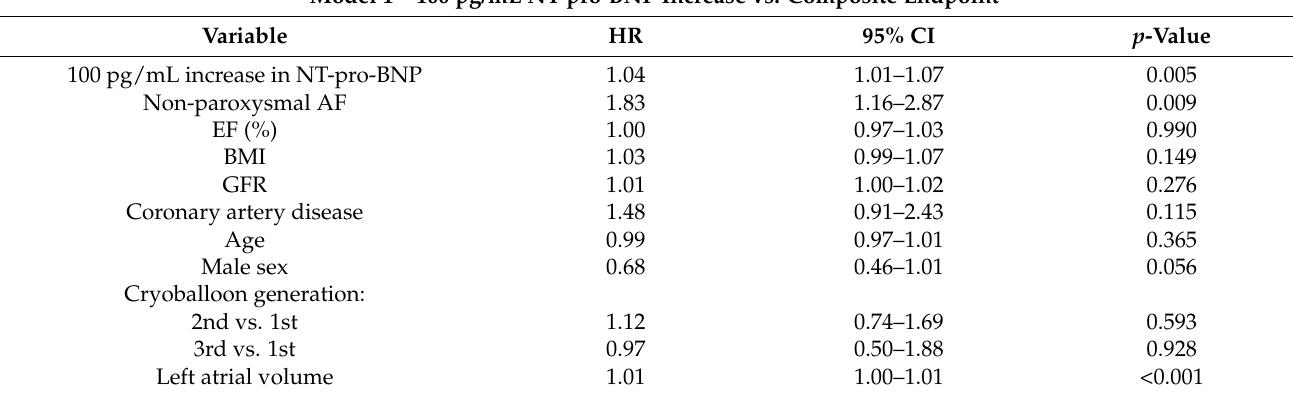
Table 2. Different multivariate Cox proportional hazards